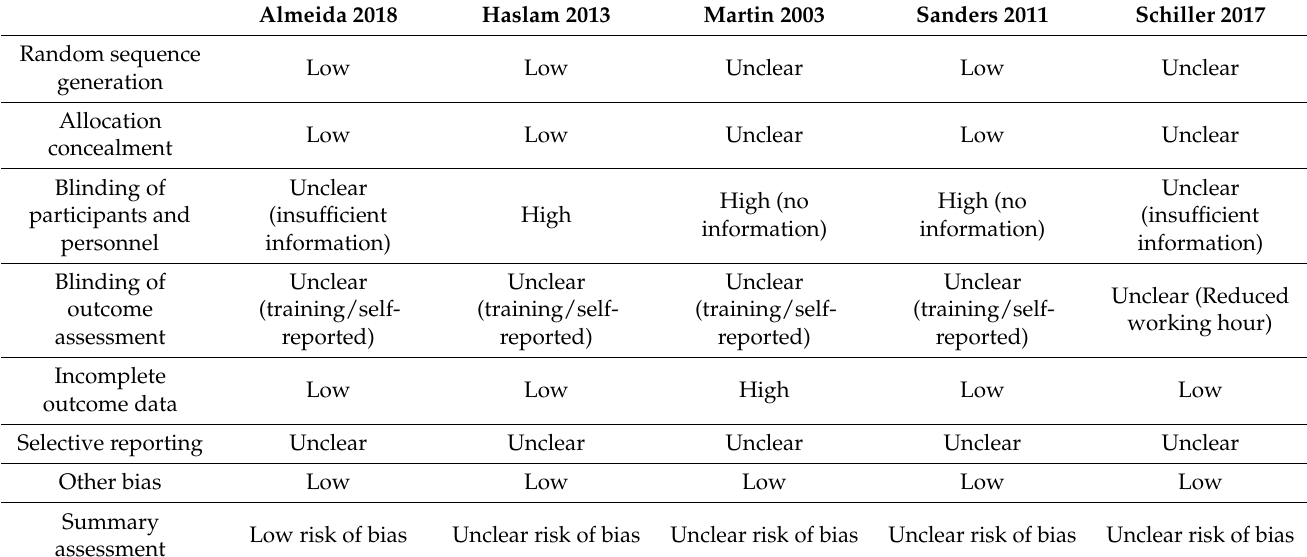
Table A2. Risk of Bias for included RCT studies.